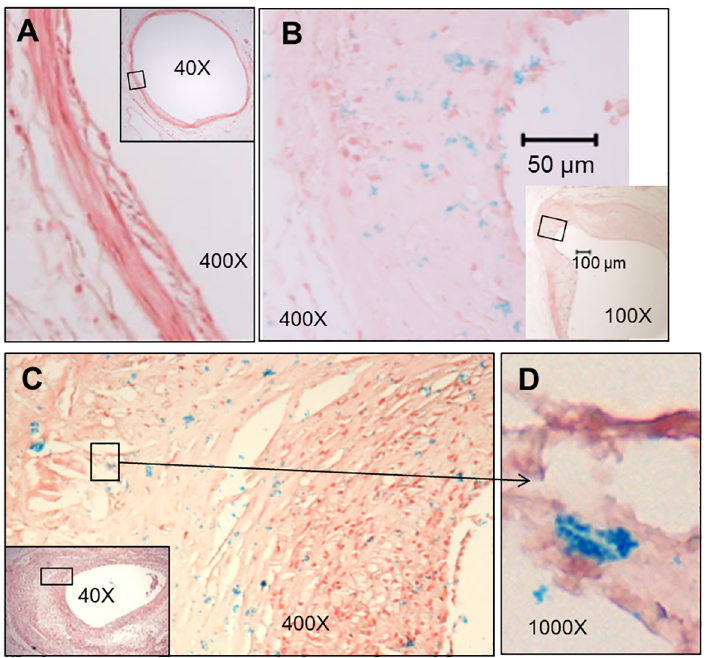
Fig 4. In situ hybridization using the H . pylori 16S rRNA probe (blue staining) demonstrating presence and absence of H . pylori in left circumflex artery sections. Sections were counterstained with Nuclear Fast Red and boxed regions of low magnification images indicate the locations of the high magnification images. A) Artery from an uninfected animal. B) Artery showing a medium infection density (blue dots). C) Artery showing a high density of bacteria. D) High magnification reveals a cluster of H . pylori suggestive of limited